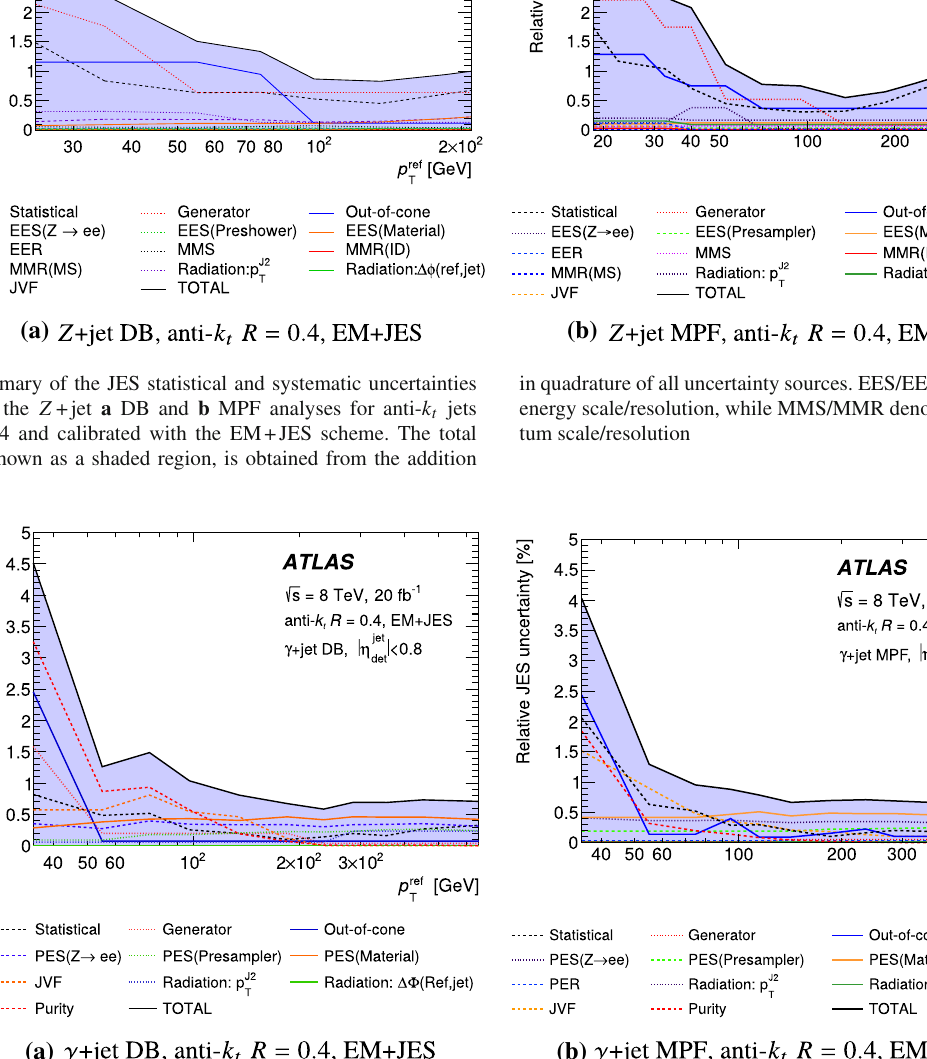
uncertainty, shown as a shaded region, is obtained from the addition in quadrature of all uncertainty sources. PES denotes the photon energy scale, while PER denotes the photon energy